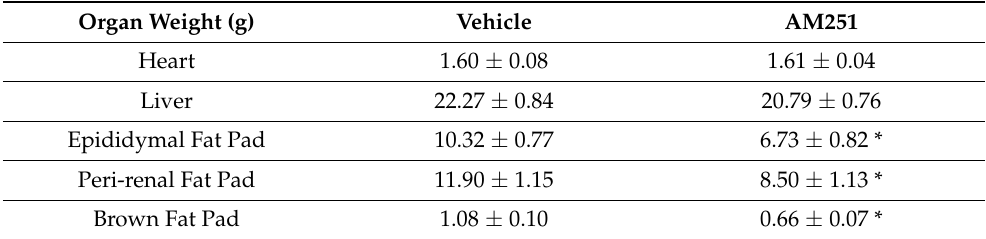
Table 1. The effect of AM251 treatment on organ weights (g). HFD fed rats were injected daily with either AM251 (3 mg/kg of body weight, ip) or vehicle for six weeks. All results are presented as a mean ± SEM from n = 10 (AM251) and n = 6–10 (vehicle) treated rats on an HFD. Significance * p ≤ 0.05 compared to